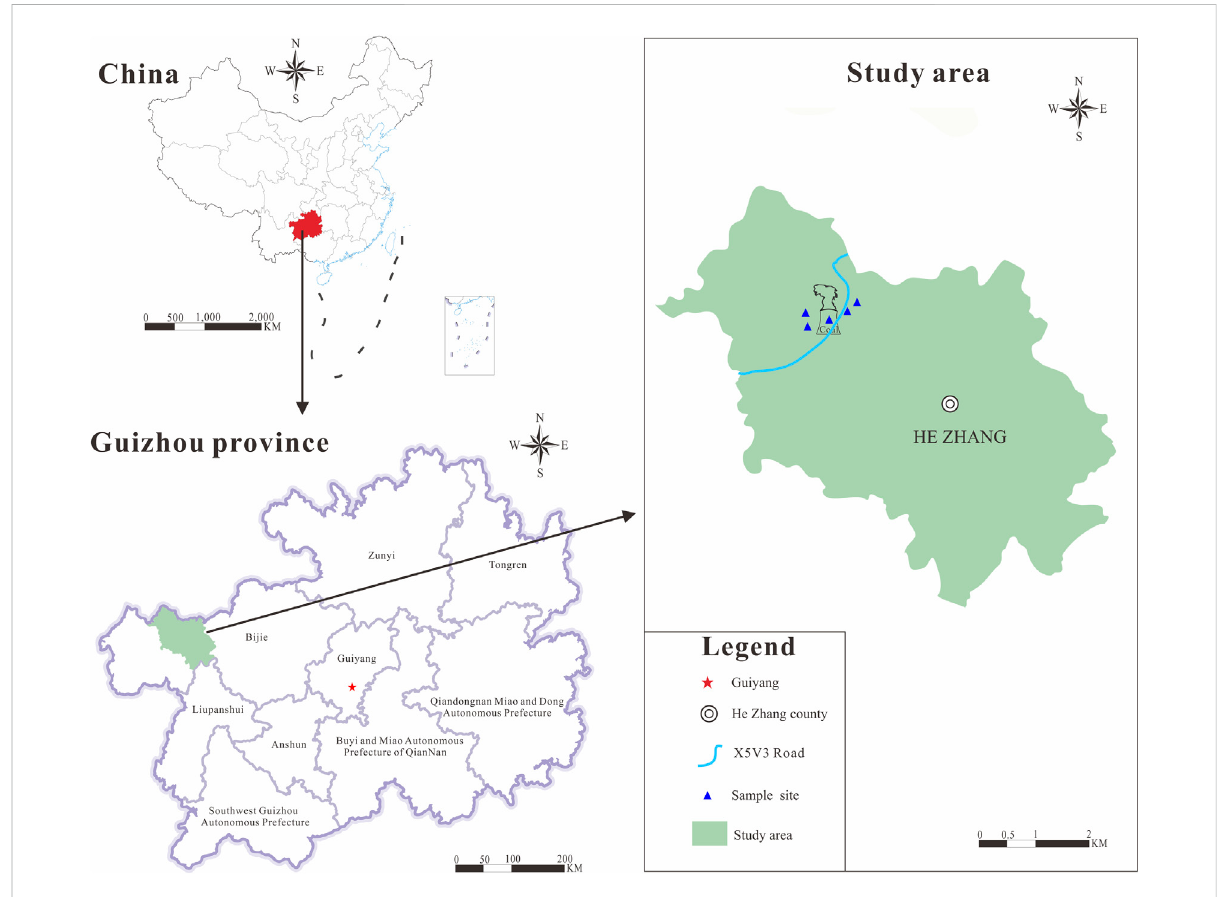
FIGURE 1 Location of samples site of karst soil in Guizhou